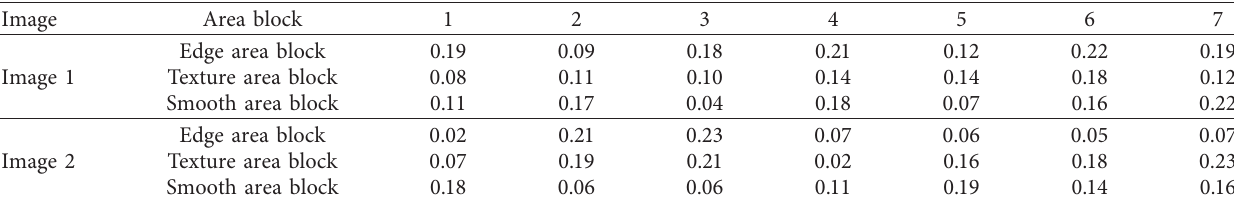
Table 1: Structure sparsity of different blocks to be repaired.